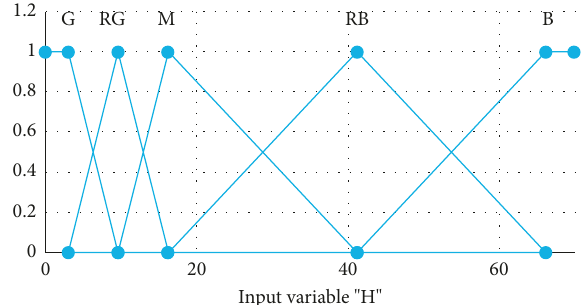
Figure 2: An example of a building height membership function as an input